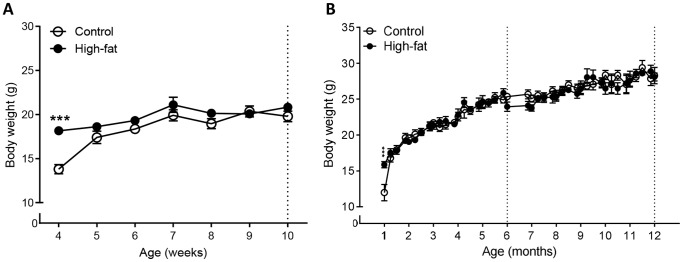
A high-fat diet during pregnancy and lactation transiently increases bodyweight in female 3xTgAD offspring.In separate groups of mice bodyweight was measured weekly after weaning between 4–10 weeks of age (approximately 2 months of age) (A) and 1–12 months (B) in female 3xTgAD offspring mice from either control or high-fat fed dams. Dashed line indicates the age at which behaviour was assessed (data are presented in Figures 3 and 4). Data are mean ± SEM for n = 5 per group. ***P<0.001 versus control fed mice.